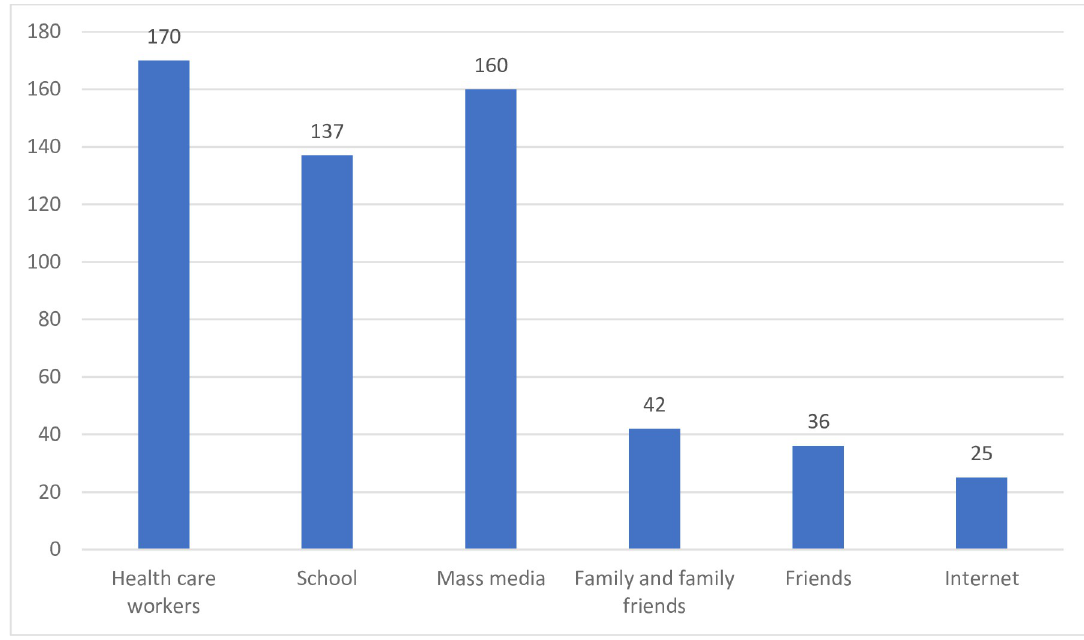
Fig 5. Source of information on HPV vaccination of adolescent school girls in ambo town, central Ethiopia, 2020. Since multiple responses are possible, the percentage could be greater than 100%.